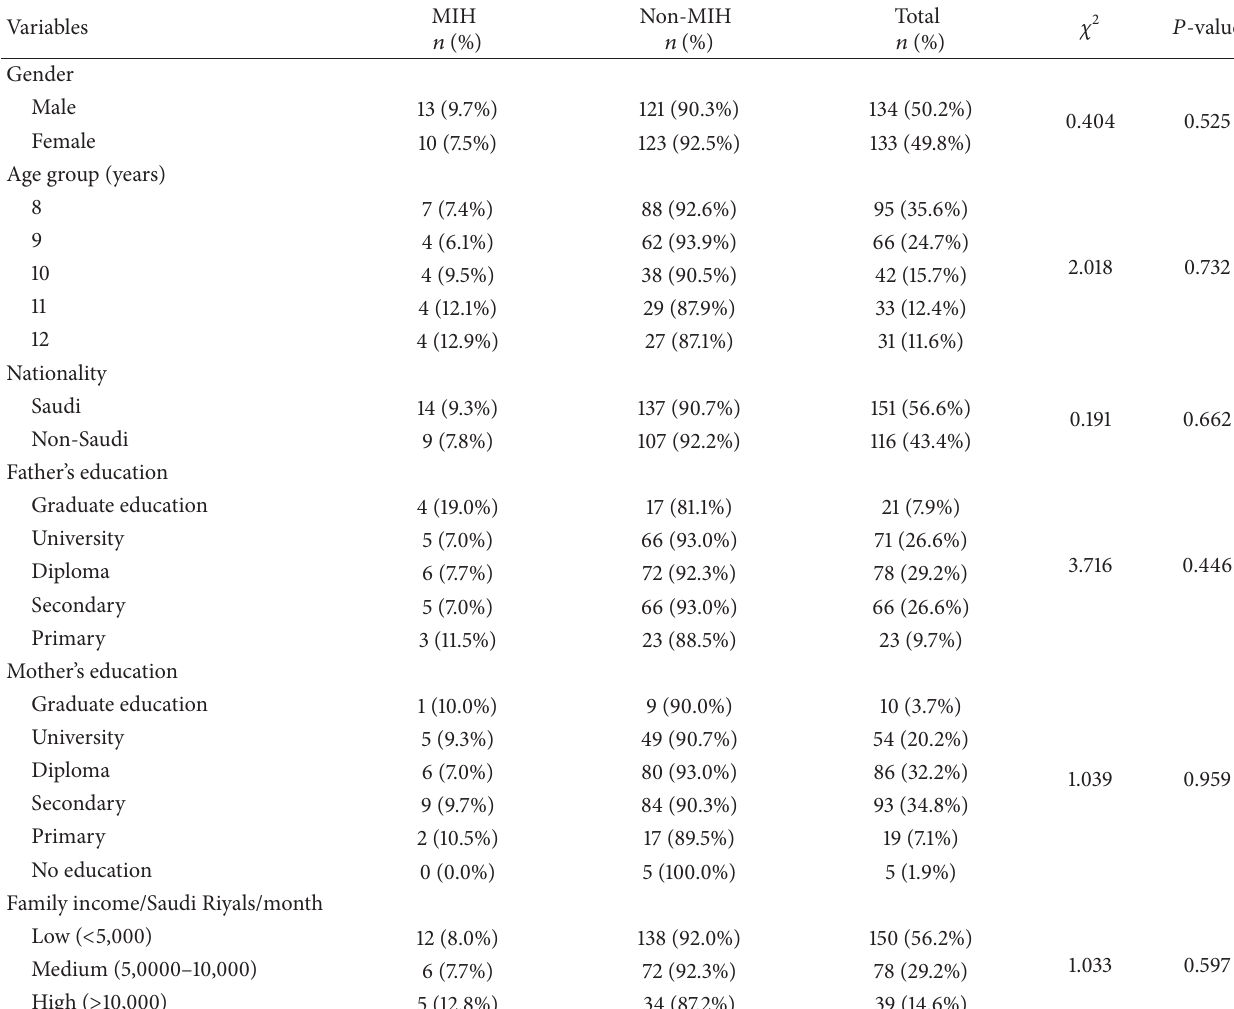
Table 2: Sample demographics.